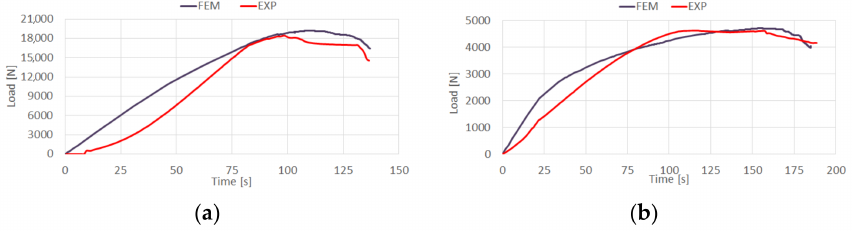
Figure 9. Comparison of post-critical equilibrium paths: ( a ) top-hat column, ( b ) channel column.